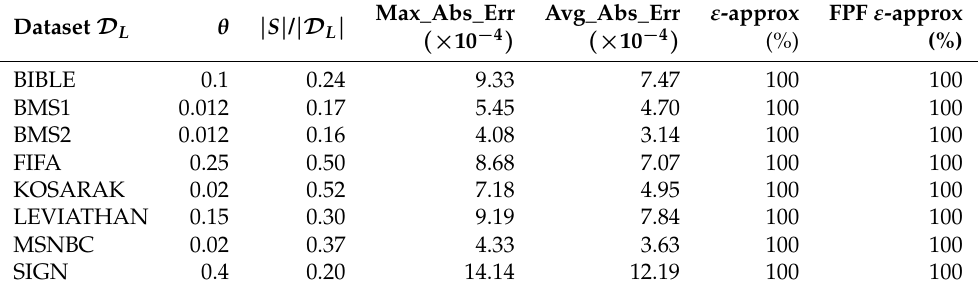
Table 2. Sampling algorithms results. For each enlarged dataset D L , we report θ , the ratio | S | / |D | between the sample size | S | and the size of the enlarged dataset |D L ( p ) | , and Avg_Abs_Err, the average max | f D ( p ) − f the maximum max p ∈ C S i i the 5 samples S i and with C i the set of frequent sequential patterns extracted from S i , the percentage of ε -approximations obtained over the 5 samples and the percentage of FPF ε -approximations obtained over the 5